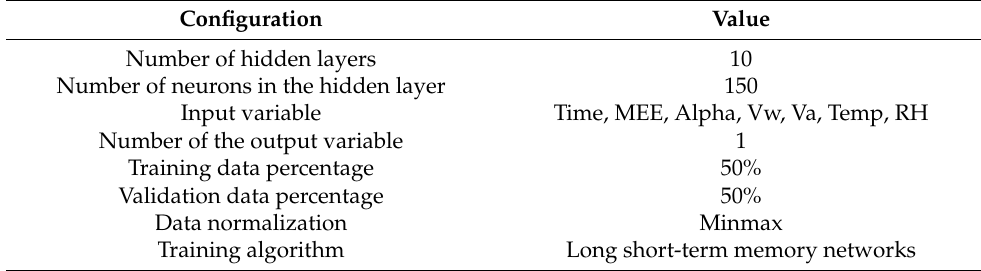
Table 1. Detailed configuration of the neural